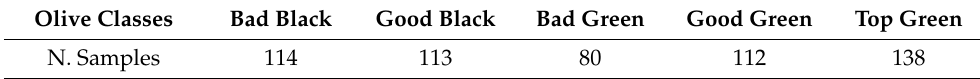
Table 1. Data set olives composition. Olive Classes Bad Black Good Black Bad Green